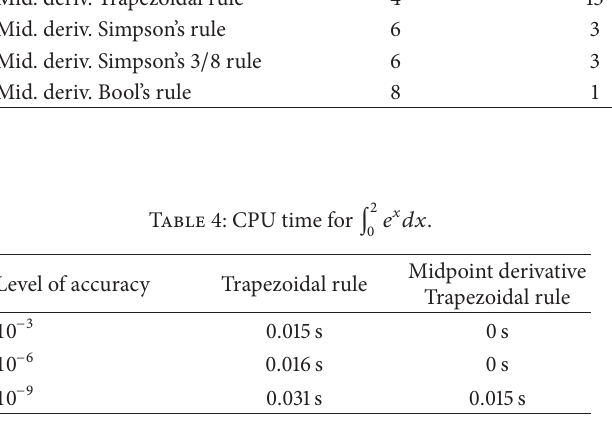
1 ( ln (1 + 𝑥)/(1 + 𝑥 2 ))𝑑𝑥 0